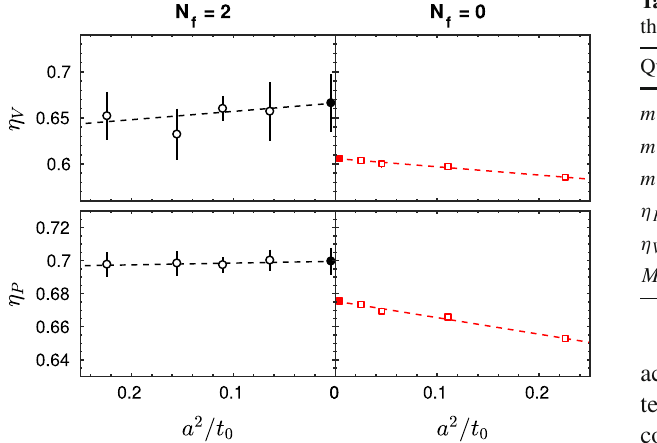
only ( [ m V / m P ] N f = 2 − [ m V / m P ] N f = 0 )/ [ m V / m P ] N f = 2 = 0 . 12 ( 7 ) %. For the hyperfine splitting ( m V − m P )/ m P this